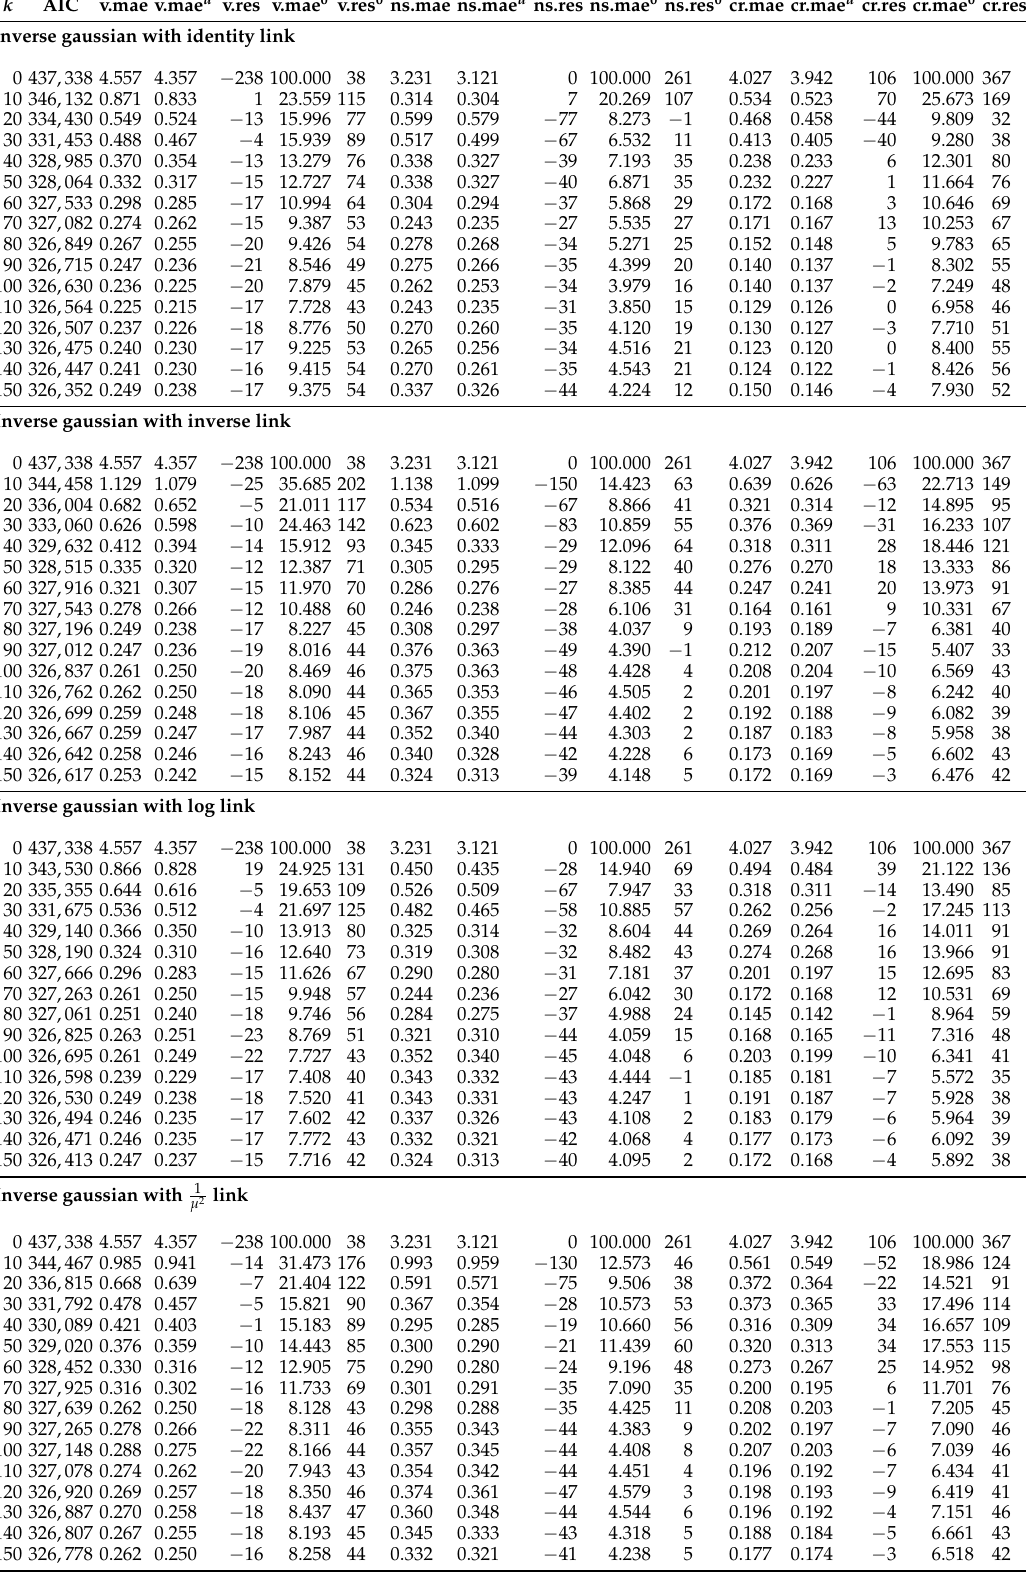
Table A10. AIC scores and out-of-sample validation figures of the inverse gaussian GLMs of BEL with identity, inverse, log and 1 link functions under 150–443 after each tenth µ 2